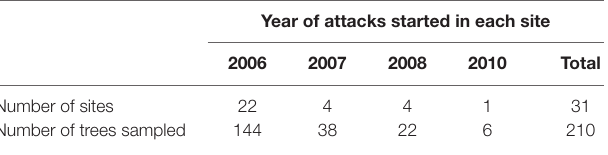
TABLe 1 | Number of study sites and residual Pinus contorta var. latifolia trees selected in each site from 2006 to 2010 during Dendroctonus ponderosae outbreak in Alberta